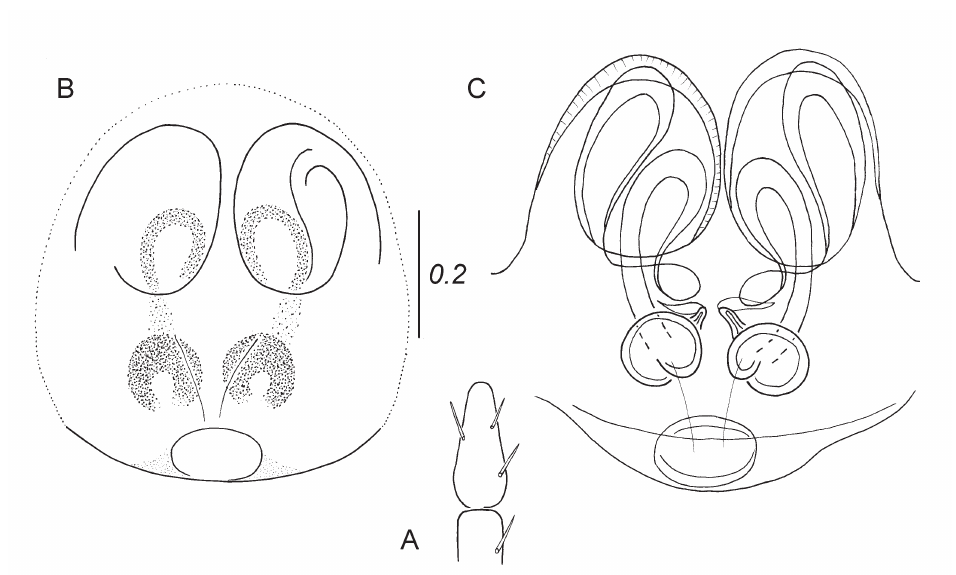
Fig. 5. Thiratoscirtus lamboji sp. nov., holotype. A . Female palp. B . epigyne. C . Internal structure of epigyne. scale bar for all figures = 0.2 mm.